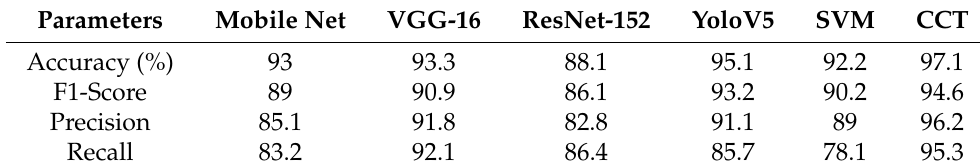
Figure 7. Benchmark models’ performances on AgriPK as shown in Table 3. Table 3. Benchmark models’ performances on AgriPK.